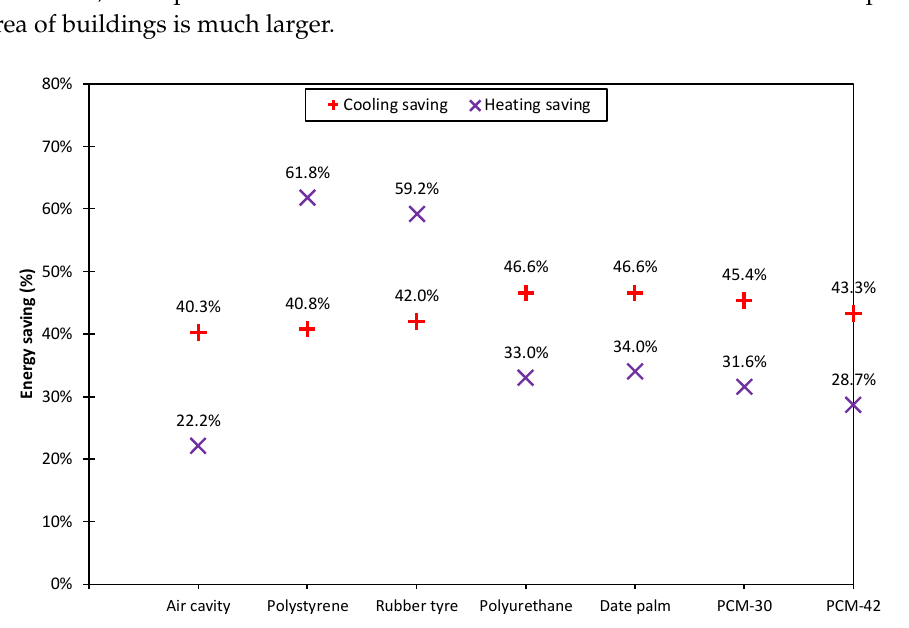
Figure 8. Energy saving using different insulations as compared to the reference in hot and cold climatic conditions.